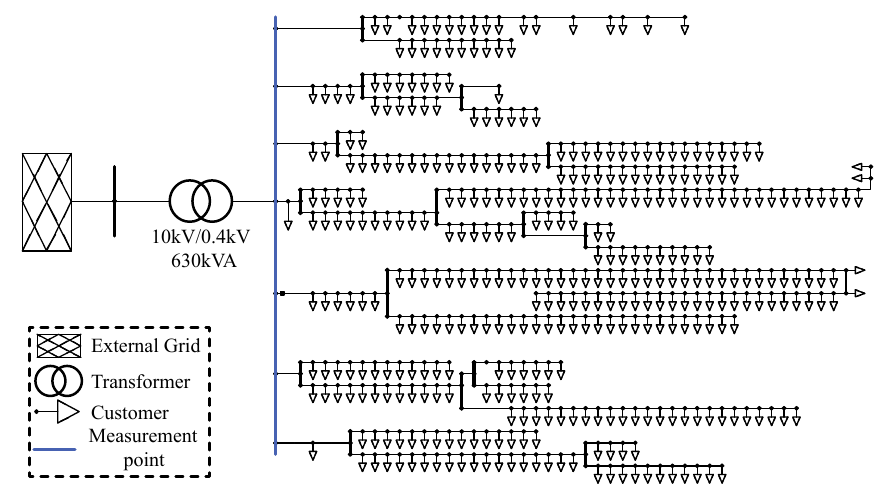
Figure 8. The topology of the LV grid used for validation.